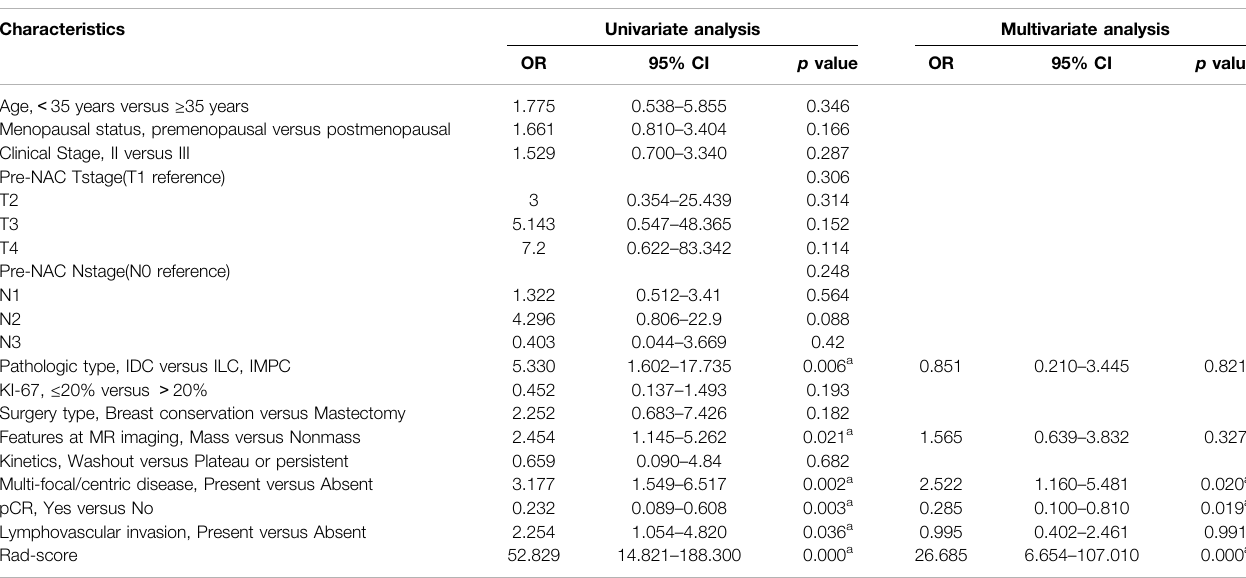
TABLE 4 | Univariate and multivariate analysis of disease-free survival in training group.